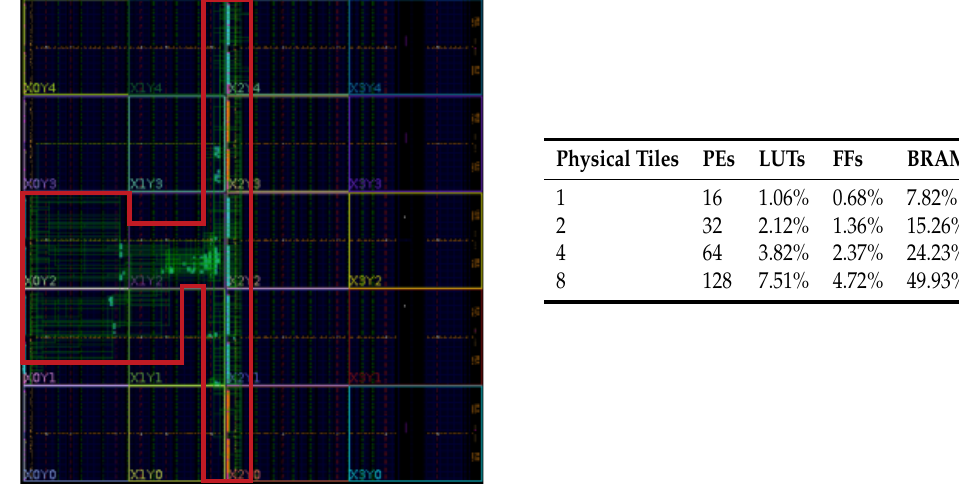
Figure 11. Result of the place-and-route process for a single physical tile ( left )—the red box highlights the area of the FPGA device where resources are used). The synthesis results for different configurations are also represented ( right )—single FPGA device.